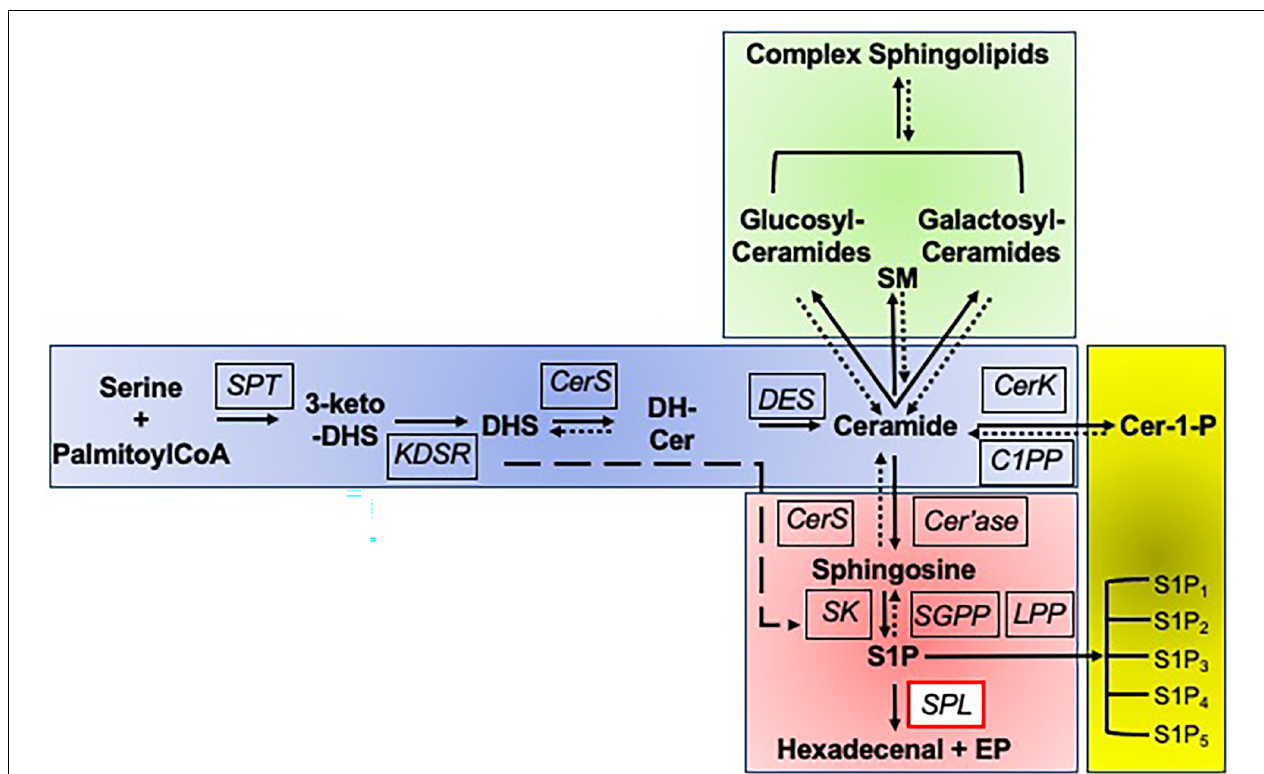
FIGURE 1 | Sphingolipid biosynthetic and degradative pathways. Sphingolipid biosynthesis is initiated by the multi-subunit enzyme serine palmitoyltransferase (SPT) which catalyzes the condensation of serine and palymitoyl CoA to form 3-keto-dihydrosphingosine (3-keto-DHS). The reduction of 3-keto-DHS by 3-ketodihydrosphingosine reductase (KDSR) results in formation of the long chain amino base, dihydrosphingosine (DHS), which is subsequently acylated at its free amino group by one of five ceramide synthases (CerS), forming dihydroceramide (DH-Cer). The reversibility of this and subsequent steps is indicated by a dotted line and arrow. Alternatively, DHS can be directly phosphorylated to DHS1P by sphingosine kinases (SK) in the degradative pathway, as indicated by the long dashed line and arrow. The delta 4-desaturase (DES) encoded by DEGS1 then introduces a double bond into the DHS backbone, forming ceramide, the central building block of all sphingolipids. From ceramide, there are three possible directions, namely biosynthesis of sphingomyelin and glycosyl sphingolipids, phosphorylation, or degradation. Ceramide can be modified by addition of a phosphocholine group at the C1 position by sphingomyelin synthase, yielding sphingomyelin (SM). It can be glycosylated with either a glucose or galactose moiety to form glucosylceramides or galactosylceramides, followed by subsequent addition of sugars to form the complex array of glycolipids, the glycosylated sphingolipids. Each of these steps is reversible, thus routing higher order sphingolipids into the degradative pathway. Ceramide can be phosphorylated to the bioactive lipid ceramide-1-phosphate (Cer-1-P) by ceramide kinase (CerK), a step that can be reversed by ceramide phosphate phosphatase (C1PP). Alternatively, ceramide can enter the common degradative pathway that breaks down sphingolipids derived from de novo biosynthesis and from the recycling of higher order sphingolipids. The degradative pathway begins with ceramide being deacylated by ceramidase (Cer’ase), generating sphingosine. Sphingosine may be reutilized by CerS to regenerate ceramide in the salvage pathway, or it may continue through the degradative pathway, being phosphorylated by SK, generating the bioactive sphingolipid S1P. S1P can activate its five cognate G protein-coupled receptors (S1P1-S1P5). Sphingosine can be regenerated from S1P by S1P-specific phosphatases (SGPP) and nonspecific lipid phosphate phosphatases (LPP). Ultimately, all cellular S1P and DHS1P